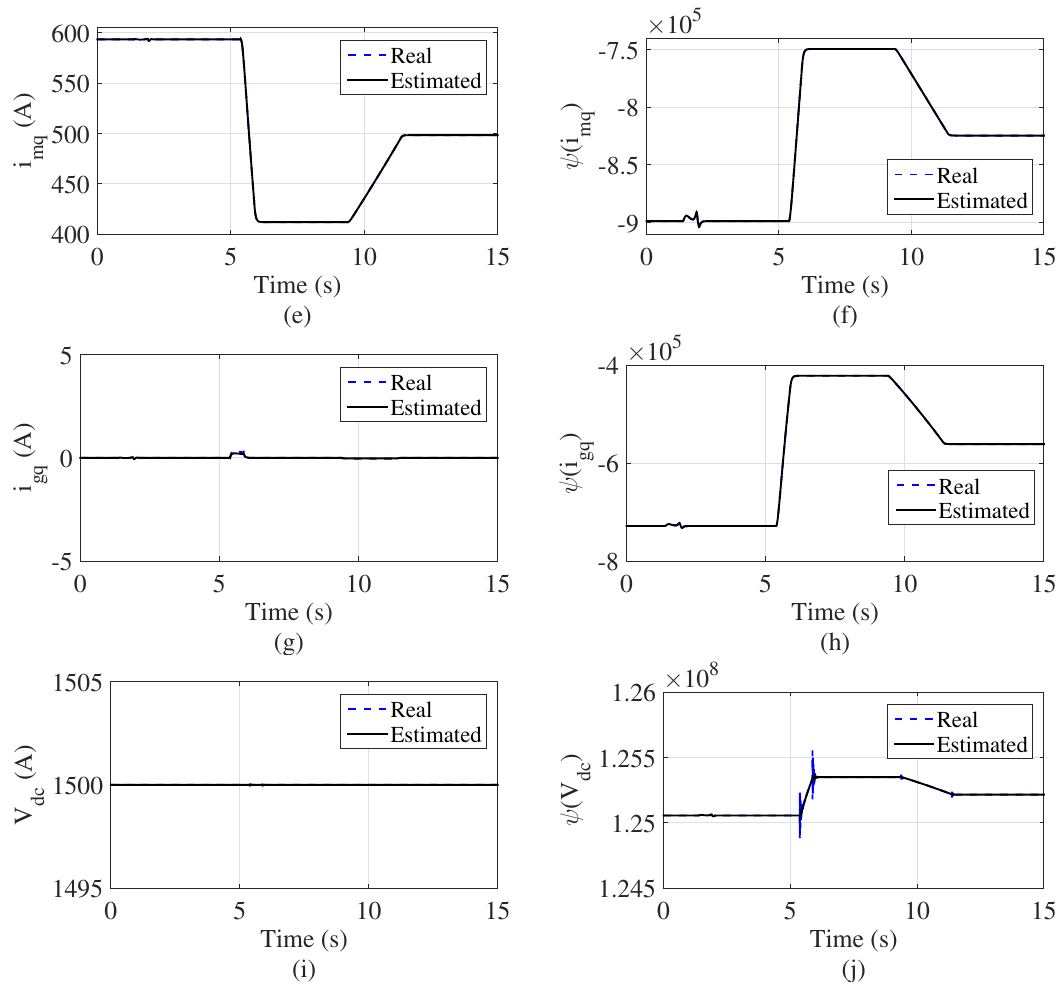
Figure 7. Estimates of states and perturbations to ramp wind speed. ( a ) Estimation of mechanical rotation speed ω m . ( b ) Estimation of perturbation term Ψ ( ω m ) . ( c ) Estimation of i md . ( d ) Estimation of perturbation term Ψ ( i md ) . ( e ) Estimation of i mq . ( f ) Estimation of perturbation term Ψ ( i mq ) . ( g ) Estimation of i gq . ( h ) Estimation of perturbation term Ψ ( i gq ) . ( i ) Estimation of V dc . ( j ) Estimation of perturbation term Ψ ( V dc )